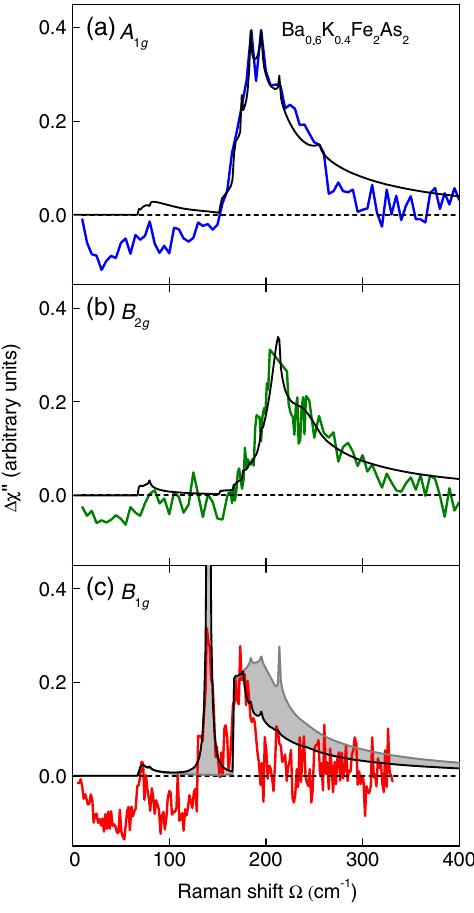
FIG. 3. Raman response and theoretical results for (a) A 1 , g (b) B 2 , and (c) B 1 symmetry in Ba 0 K 0 Fe 2 As 2 . Shown is the g g . 6 . 4 difference Δ χ 00 of the response at 8 and 45 K (for raw data, see Ref. [40]). In this way, temperature-independent phonon lines and the particle-hole continuum are subtracted out, not being described by the weak-coupling theory. As an undesired side effect, the experimental intensities become negative inside the gap while the theoretical spectra just vanish. The sum of contributions from all bands is shown in black. Figure 5 of Appendix A shows a breakdown of contributions from individual bands. (c) The gray shaded area is the spectral weight transferred from the pair-breaking region into the collective mode.